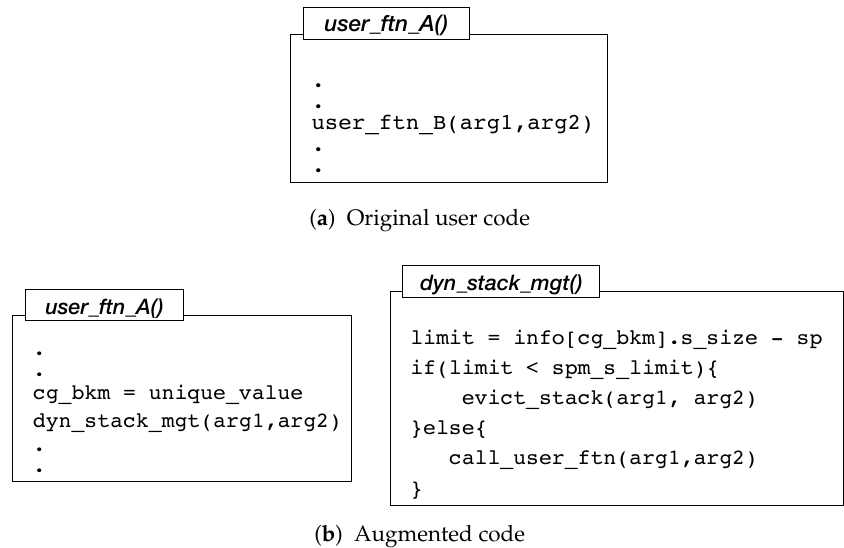
Figure 13. Code augmentation for dynamic stack data